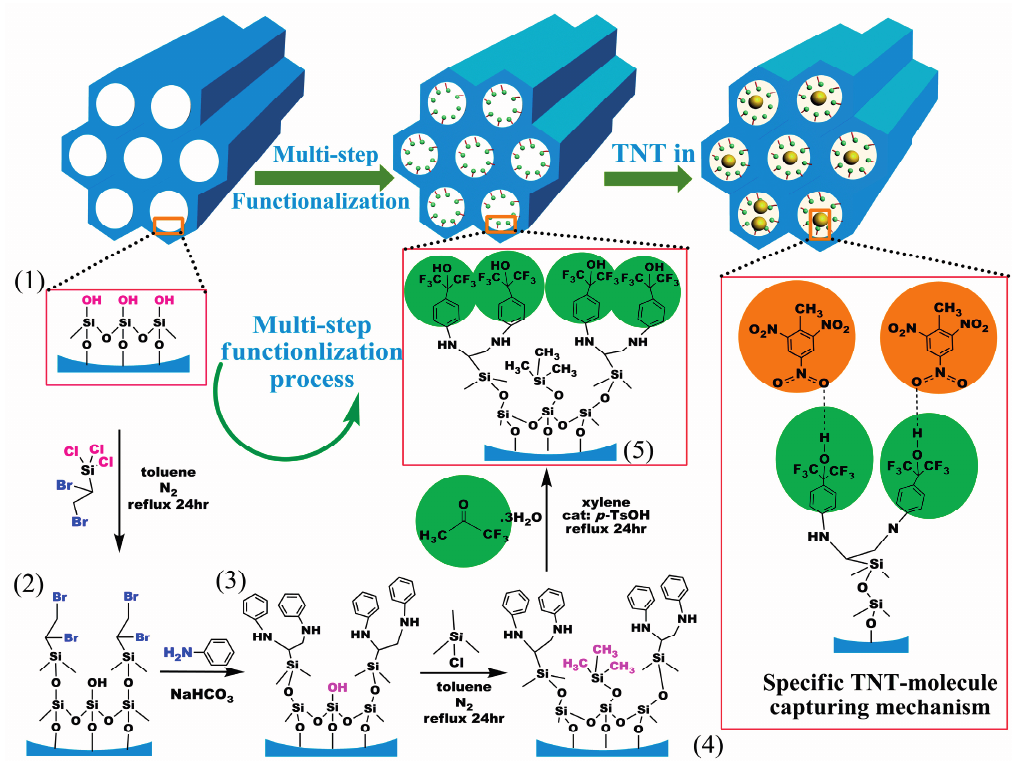
Figure 8. Modification scheme of the HFIP sensing groups onto the inwall of SBA-15 mesoporous-silica and the specific capturing mechanism of the functionalized nano-material to TNT molecules. Reprinted with permission from